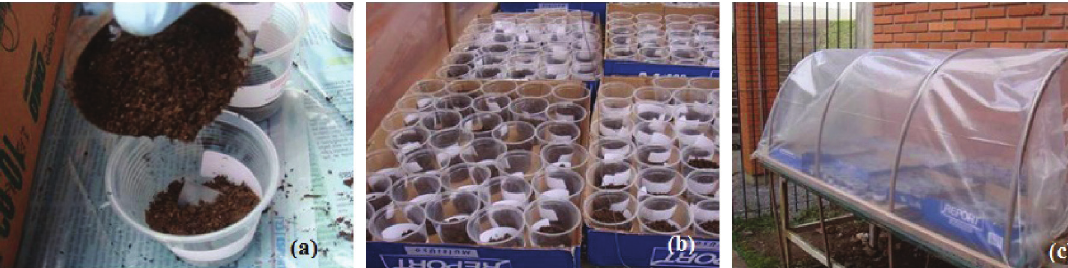
Figure 2. Exposure of samples in (a) cups with the simulated soil and the polymeric samples, (b) greenhouse dispose and (c) greenhouse.